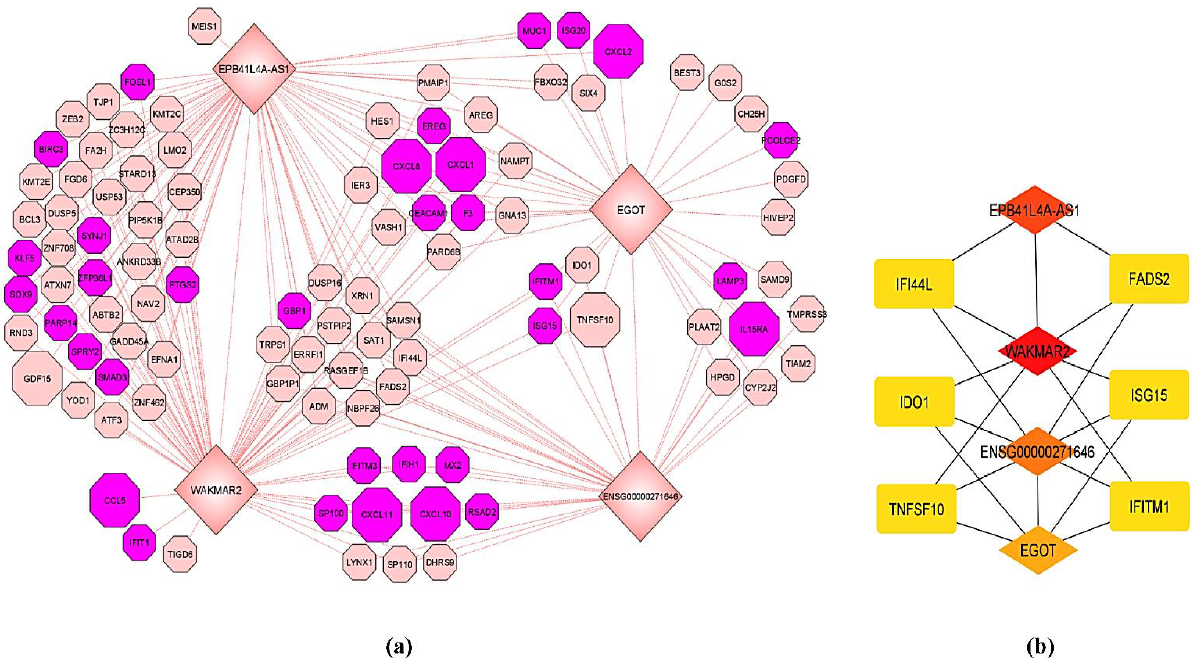
Figure 6. ( a ) mRNA-lncRNA co-expression network of the blue module. lncRNAs are represented by diamond shapes. The genes highlighted in purple belong to the enriched biological process “response to cytokines.” The genes represented by large octagon shapes represent the enriched KEGG pathway “cytokine-cytokine receptor interaction.” ( b ) Sub-network of the top ten hub nodes. Increasingly red color represents higher-scoring nodes.